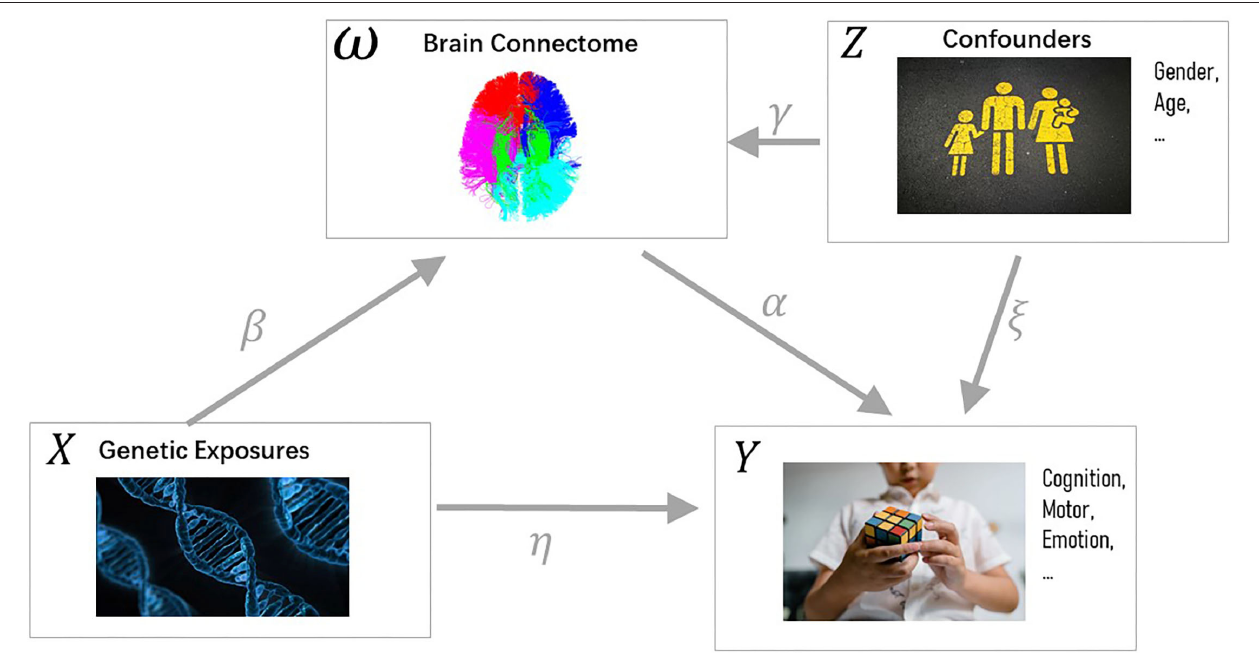
FIGURE 1 | Casual pathway diagram. Variables are colored black while parameters are colored gray. The independent variable X denotes the genetic exposure. The dependent variable Y is the cognitive trait. The brain connectomes ω act as the mediator, which transmits the indirect effect of X to Y . Both ω and Y are affected by confounders Z (e.g., gender, age). Source corresponding to letter Z, top-right: https://unsplash.com/photos/KhStXRVhfog; source corresponding to letter X, bottom-left: https://pixabay.com/illustrations/dna-biology-medicine-gene-163466/; Source corresponding to letter Y, bottom-right: https://www.pexels.com/photo/